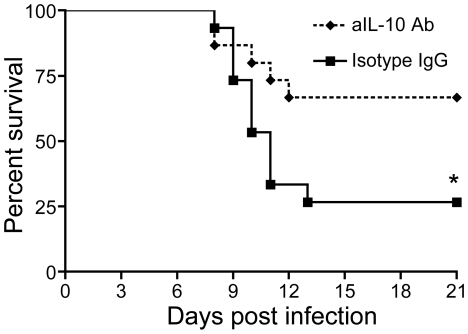
Pharmacologic neutralization of IL-10 increases survival of WNV-infected mice.Wild-type (WT) mice were i.p. challenged with WNV (LD50). Mice received two i.p. injections of anti-IL-10 monoclonal antibody (aIL-10 mAb, 200 µg/dose) or isotype control IgG on day 2 and day 3 p.i. (p<0.05, n = 15/group). Data were pooled from three independent experiments. * p<0.05.